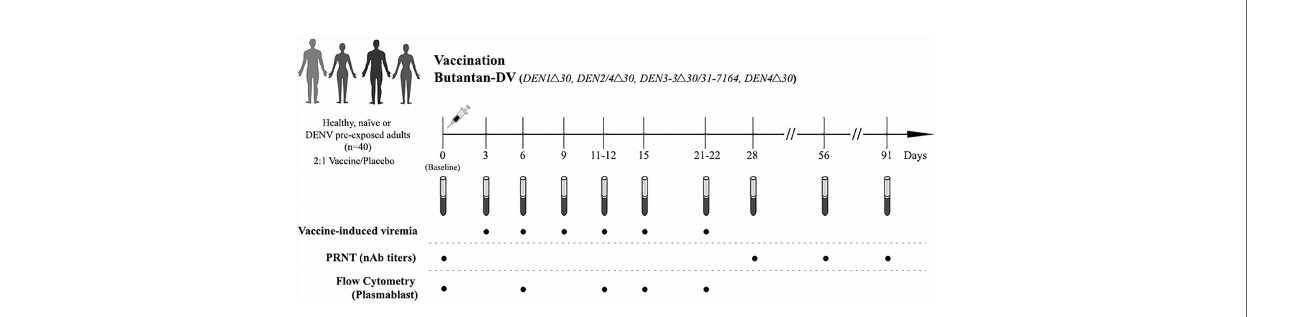
FIGURE 1 | Study design. Naïve and DENV-pre-exposed volunteers received a single subcutaneous dose of the lyophilized vaccine consisting of 1,000 PFU of each attenuated virus or placebo (quali fi ed Leibovitz L-15 medium only). Blood samples were collected pre-vaccination (baseline, day 0) and at days 3, 6, 9, 11-12, 15, 21-22, 28, 56 and 91 post-vaccination, and used for the assessment of vaccine induce-viremia, DENV neutralizing antibodies (nAbs) titers using plaque reduction test (PRNT), and plasmablast responses using fl